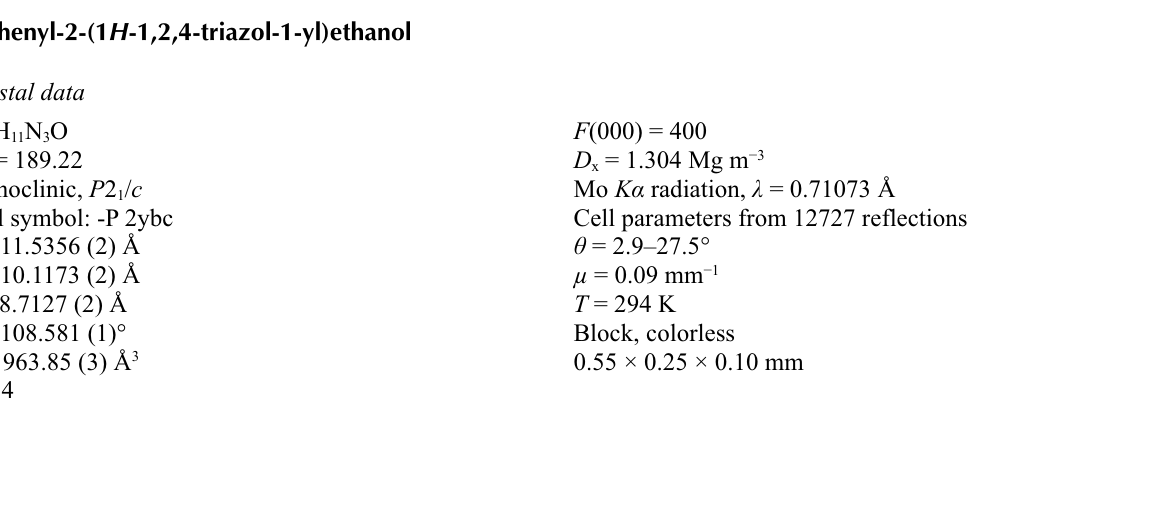
Figure 2 A packing diagram of (I). Hydrogen bonds are shown as dashed